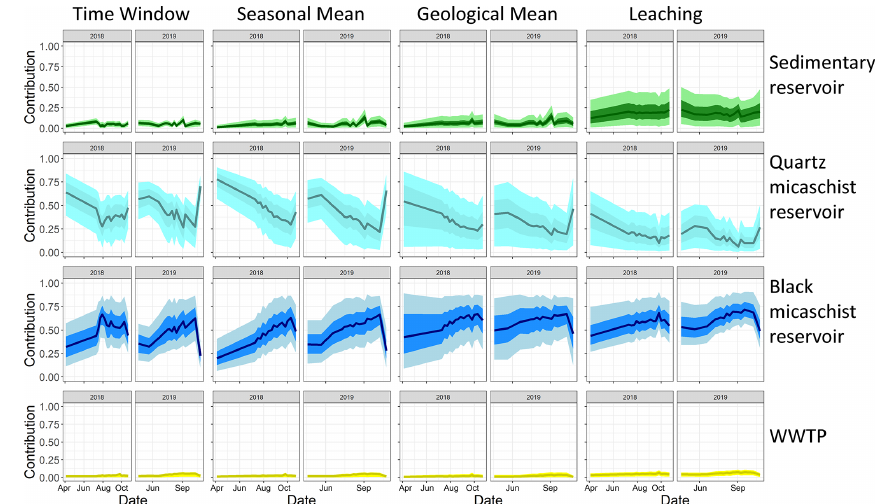
Figure 11. Mixing model result uncertainties for different contributions. The green colour represents the contribution of the limestones, the cyan represents the contribution of the quartz mica schists, the dark blue represents the contribution of the black mica schists and the yellow represents the contribution of the WWTP waters. For each variable the central line is the median value of the model, the outer limits are the limits of the model (respectively 5% and 95%) and the limit of the darker colours corresponds to the quantile of the model. The contributions are expressed in an index ranging between 0 and 1, where 1 corresponds to the sum of the contribution.